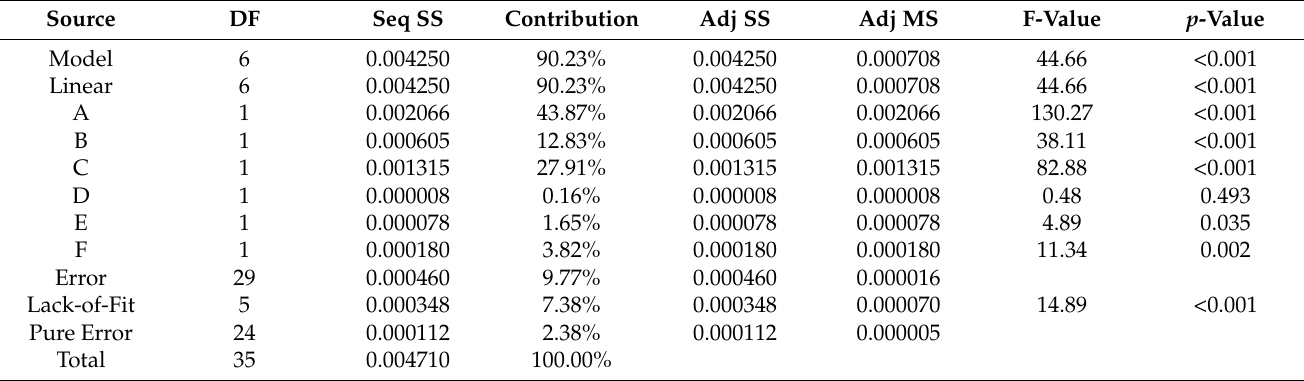
Table 6. The ANOVA table for the PB design of carbon sources.